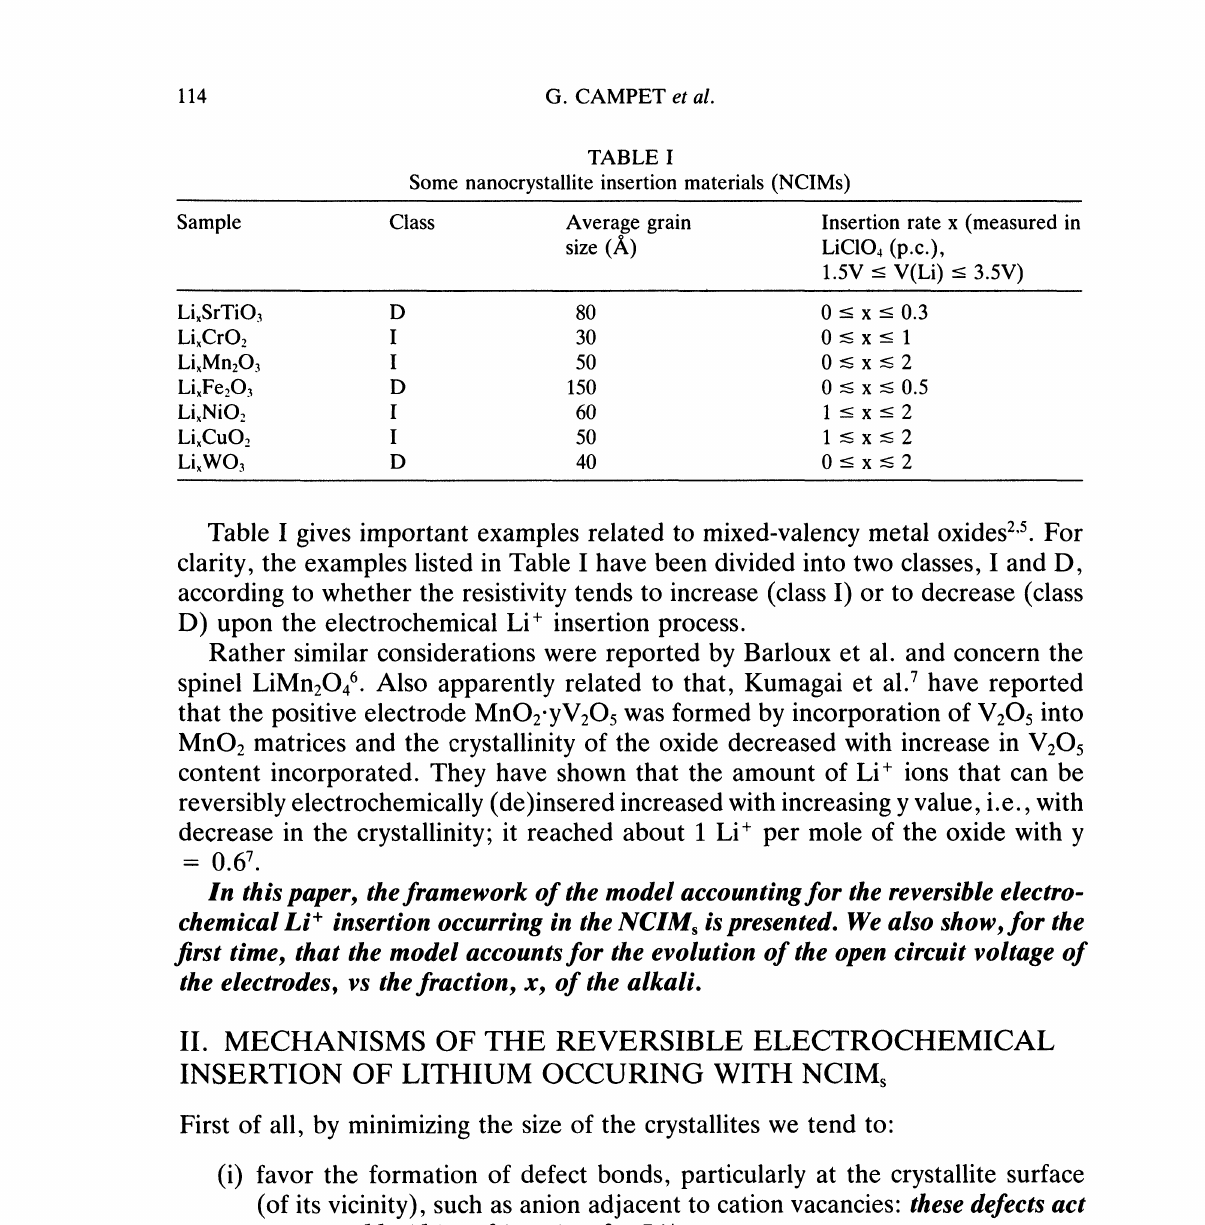
Some nanocrystallite insertion materials